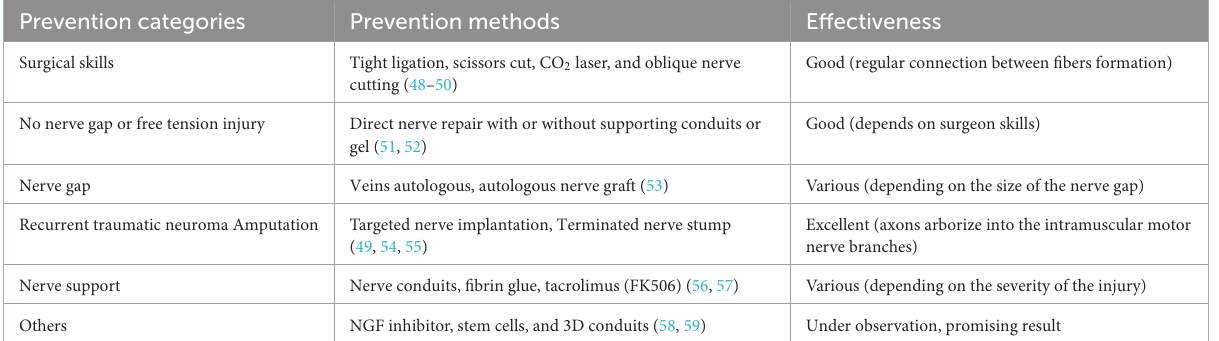
TABLE 3 Possible methods during or post-operation for prevention of traumatic neuromas